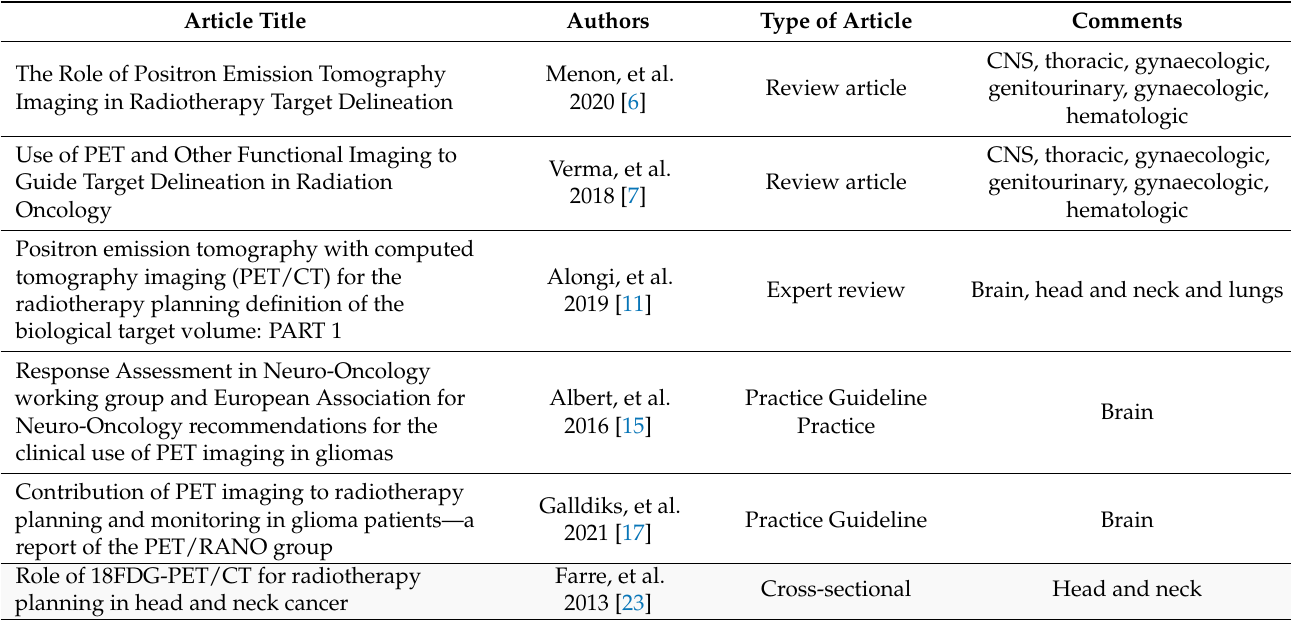
Table 1. Summary of the studies included for the